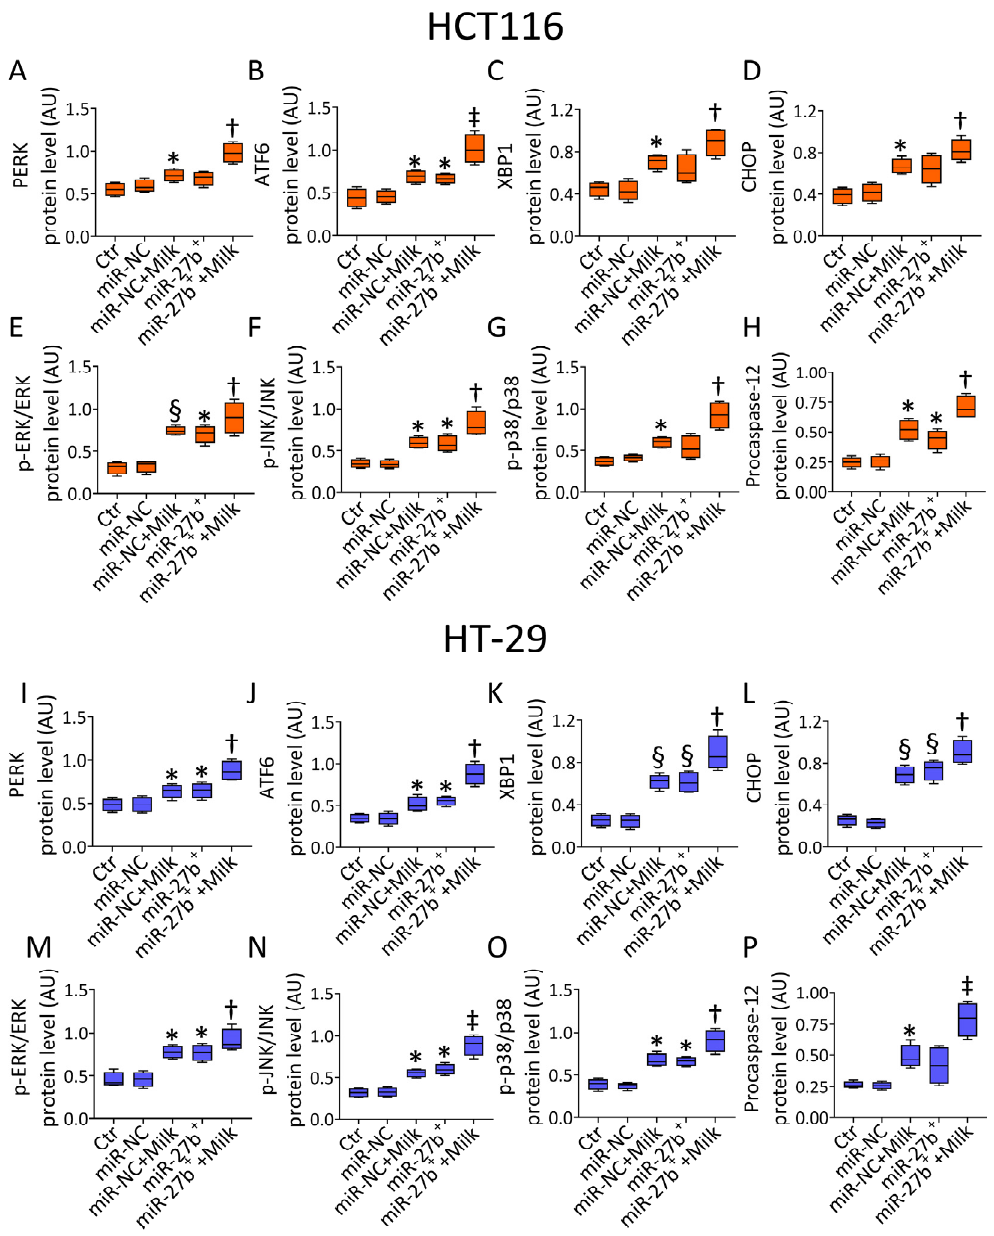
Figure 7. MiR-27b + +Milk modulated ER-stress markers. Representative immunoblotting analysis of PERK, ATF6, XBP1, CHOP, phospho-ERK/ERK, phospho-JNK/JNK, phospho-p38/p38, and procaspase-12 in ( A – H ) HCT116 and ( I – P ) HT-29 cells transfected with 30 nM mimic Negative Control (miR-NC) and miR-27b mimic (miR-27b + ) or with miR-NC and miR-27b + before 72 h with 40% v / v milk treatment (miR-NC + Milk and miR-27b + + Milk). Control cells (Ctr) were treated with the corresponding highest volume of HBSS-10 mM Hepes. Results ( n = 4) are expressed as arbitrary units (AU). * p < 0.05 vs. miR-NC; § p < 0.01 vs. miR-NC; † p < 0.05 vs. miR-27b + ; ‡ p < 0.01 vs. miR-27b + .